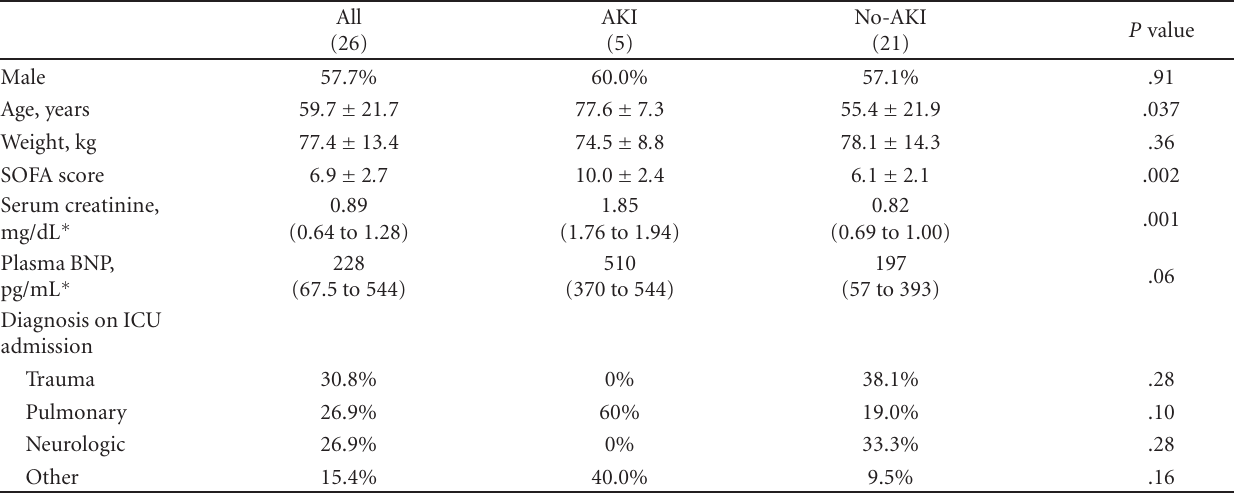
Table 1: Characteristics of AKI and no-AKI patients at ICU admission.